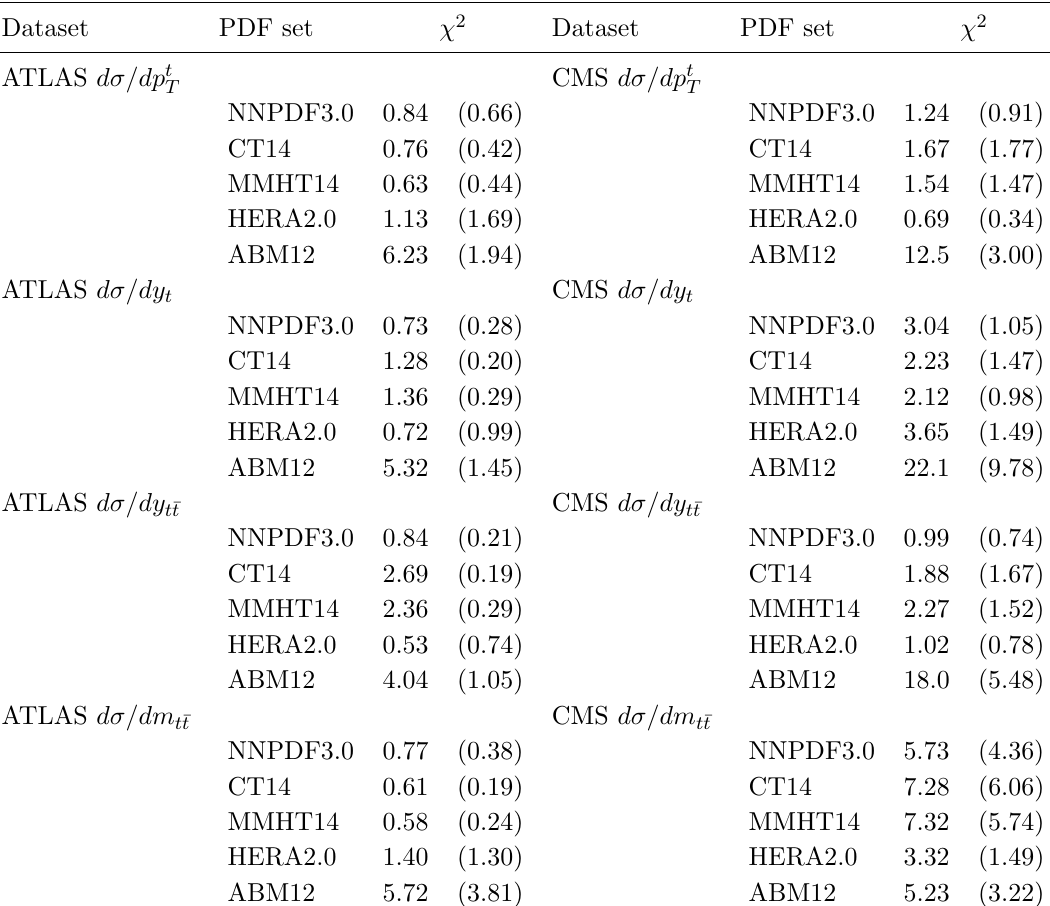
Table 3 . The (cid:31) 2 values for absolute distributions in top-quark pair production from ATLAS and CMS for di(cid:11)erent NNLO PDF sets. The (cid:12)rst number is the (cid:31) 2 from the full covariance matrix, eq. (3.5), while the value in parenthesis is obtained by adding in quadrature statistical and systematic